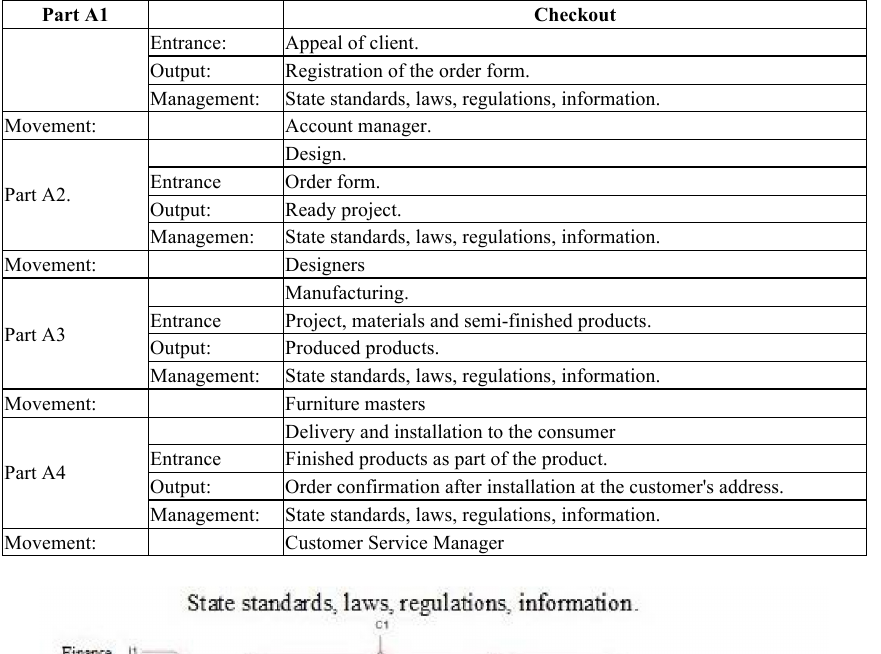
Table 1. Schema Produktion (Second Level).